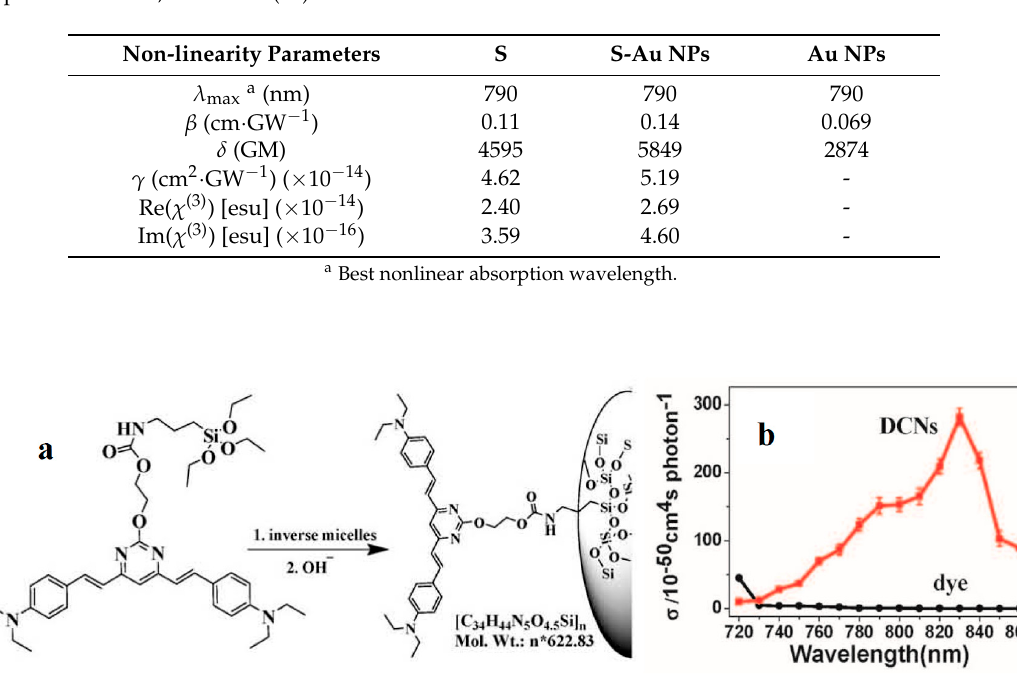
Figure 9. ( a ) Schematic representation of the preparation progress of dye-concentrated nanoparticles (DCNs) ( 52 ); ( b ) 2PA cross section of dye and DCNs in DMF versus excitation wavelengths from 720 nm to 860 nm in DMF.